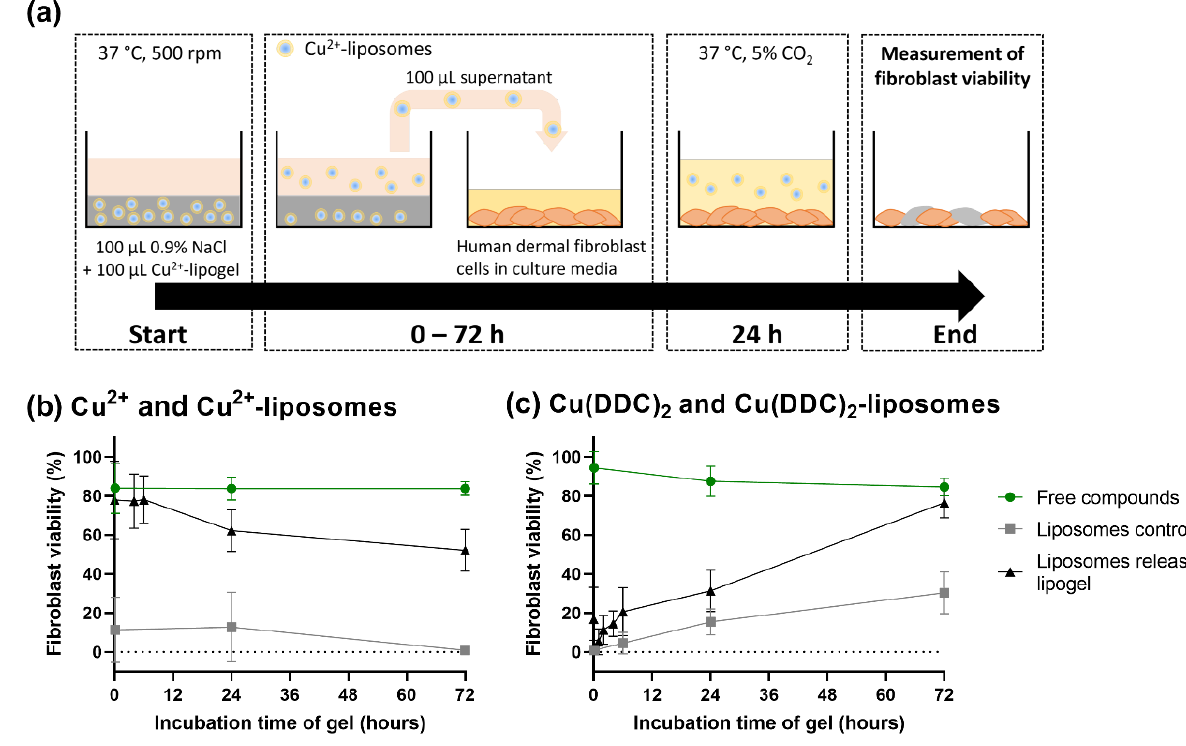
Figure 7. Effect on human dermal fibroblast cell viability of liposomes released from sterile chitosan with β -glycerophosphate (CS- β GP) gel over 72 h. ( a ) Experimental procedure exemplified with release of Cu 2+ -liposomes from the Cu 2+ -lipogel over 72 h. Cu 2+ -lipogel was covered with release media and incubated at 37 ◦ C and 500 rpm. After predetermined timepoints, the supernatant was transferred onto human dermal fibroblast cells. Following 24 h incubation, fibroblast viability was measured using CellTiter-Glo viability assay. ( b ) Effect on fibroblast viability of released Cu 2+ -liposomes from Cu 2+ -lipogel over time. Controls include the effect of free Cu 2+ incubated with sterile CS- β GP gel (corresponding to 100% released non-liposomal Cu 2+ ) and of Cu 2+ -liposomes incubated with sterile CS- β GP (corresponding to 100% released Cu 2+ -liposomes). ( c ) Effect on fibroblast viability of released Cu(DDC) 2 -liposomes from Cu(DDC) 2 -lipogel over time. Controls include the effect of free Cu(DDC) 2 incubated with sterile CS- β GP (corresponding to 100% released non-liposomal Cu(DDC) 2 ) and of Cu(DDC) 2 -liposomes incubated with sterile CS- β GP (corresponding to 100% released Cu(DDC) 2 -liposomes). Data are expressed as mean ± standard deviation (n = 3).